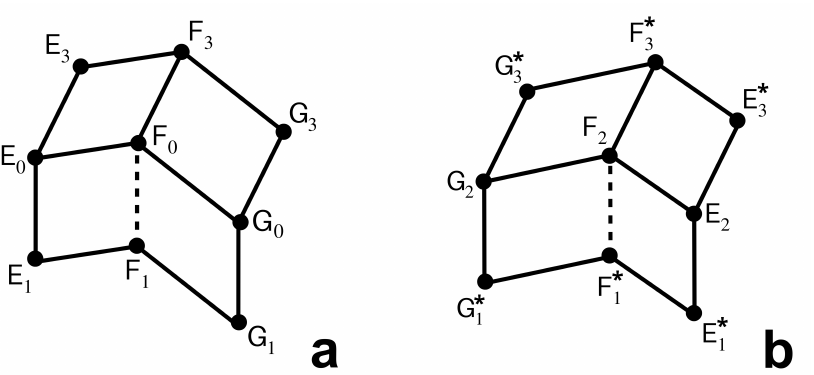
Figure 2. ( a ) Vertices of the basic asymmetric degree-four vertex cell, C 1 . ( b ) Vertices of the comple- mentary degree-four vertex cell, C 2 . The points X ∗